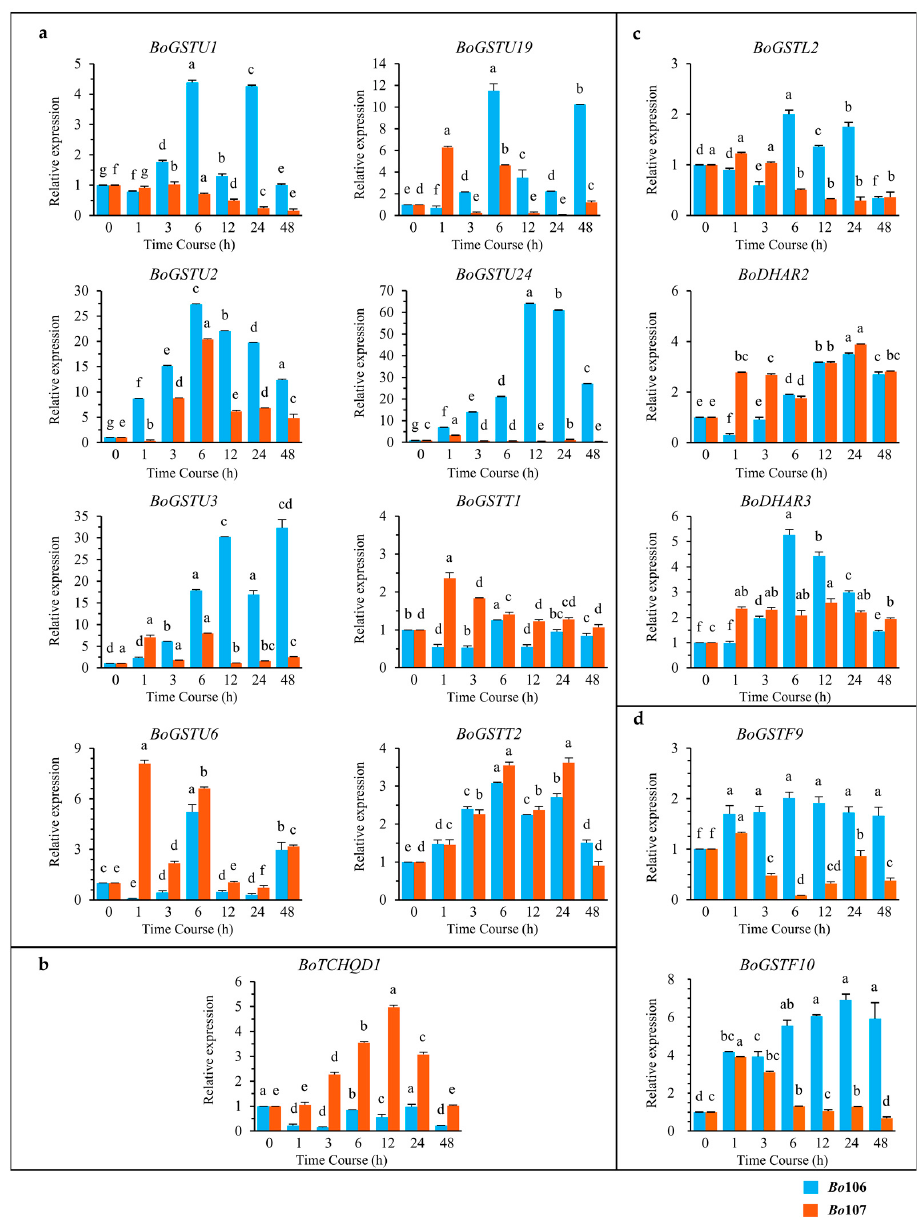
Figure 7. Relative quantitative (RQ) expression analysis of 14 BoGST genes which are involved in: ( a ) transcription activation; ( b ) signal perception in plasma membrane; ( c ) H 2 O 2 reduction in chloroplast; and ( d ) co-regulated genes in anthocyanin sequestration to the vacuoles after cold stress treatment in Brassica oleracea . X -axis represents Time Course (0, 1, 3, 6, 12, 24, and 48 h) and Y -axis represents relative mRNA expression. Graph with orange line is CT line ( Bo 106), blue line is CS line ( Bo 107). For each gene, data are represented as relative expression levels to the levels measured at 0 h (2 −ΔΔ C t ). Graph shows the mean of three biological replicates ± standard deviation. (a–e) lowercase letters represent significant differences between different time courses (one-way ANOVA, Tukey’s Test, p < 0.05).